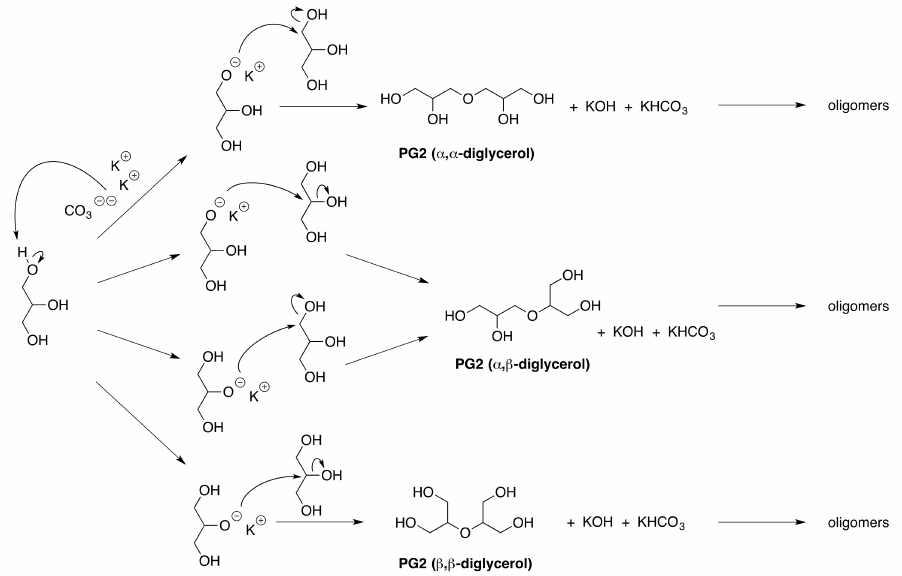
Scheme 1. Mechanism pathway for the oligomerization of glycerol in the presence of K 2 CO 3 .